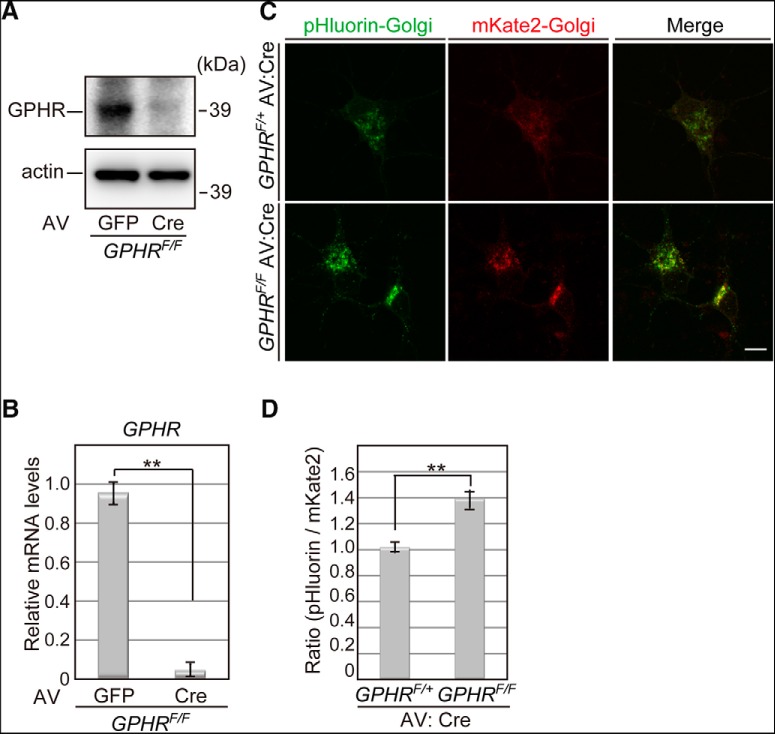

Altered luminal pH of the Golgi apparatus in GPHR deficient primary cultured neurons. A, Immunoblot analysis in primary cultured neurons from GPHRF/F mice with adenovirus (AV)-based exogenous expression of GFP or Cre recombinase. Nine days after infection, total cell lysates were subjected to immunoblot analysis for GPHR and actin. Data are representative of three independent experiments. B, Quantitation of mRNA levels of GPHR in primary cultured neurons manipulated, as described in A. Data are presented as the mean ± SEM; n = 6 for each group; **p < 0.01 (unpaired Student’s t test). C, Fluorescence images of pHluorin-Golgi in primary cultured neurons from GPHRF/+ and GPHRF/F mice with AV-based exogenous expression of Cre recombinase. Two days after infection, pHluorin-Golgi-IRES-mKate2-Golgi was transfected. Fluorescence images were taken seven days after transfection. Data are representative of three independent experiments. Scale bar: 20 µm. D, Quantification of the pHluorin/mKate2 fluorescence ratio in primary cultured neurons manipulated as described in C. Data are presented as the mean ± SEM; n = 5 for each group; **p < 0.01 (unpaired Student’s t test).